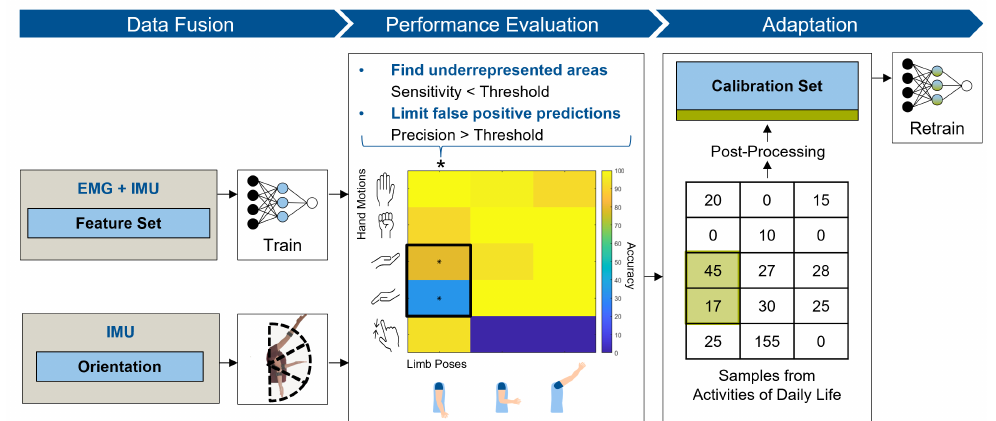
Figure 1. A schematic overview of the multi-modal adaptive algorithm. The method consists of 3 steps: (1) Data fusion: EMG and IMU data are fused to train the calibration model; pose estimation labels are generated and fused with the hand motion labels. (2) Performance evaluation: Sensitivity and precision are evaluated for each combination of hand motion and limb pose, to identify classes in need of adaptation (marked with a star). (3) Adaptation: A further unsupervised stage with labels generated by the reference classifier is taken into account. Sample points are sorted along hand motion and limb pose. The matrix is compared to the previously identified states and potential sample points are marked (marked in green). Post-processing is applied to the sample points to reduce the probability of adapting wrongly labeled data points. Adaptation of the calibration set is conducted and the model gets